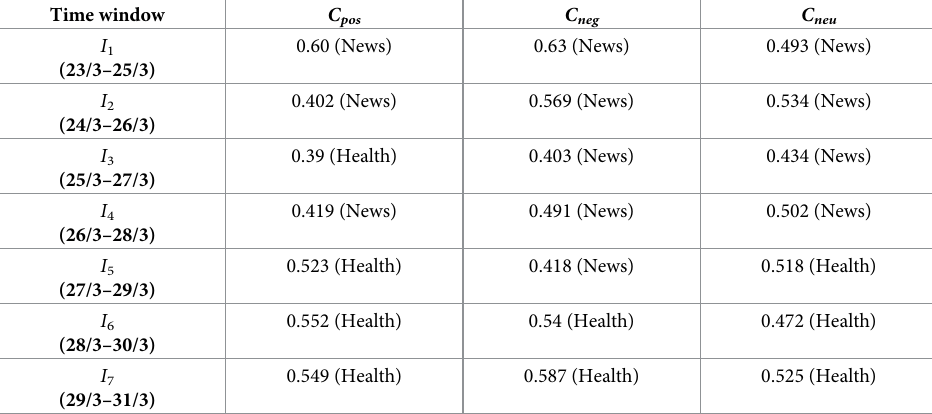
Table 9. Schematic cohesion of sentimental clusters at different I m